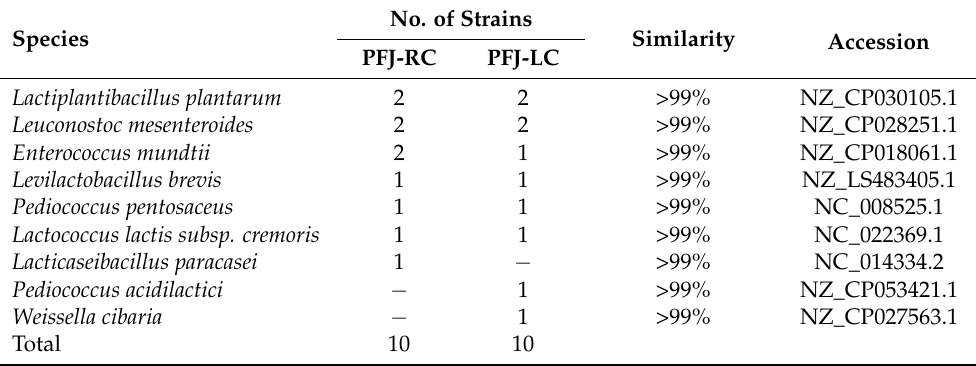
Table 2. Lactic acid bacteria species isolated from pre-fermented juice made from chopped red clover and lucerne and identified by 16s rRNA sequencing (n = 3).